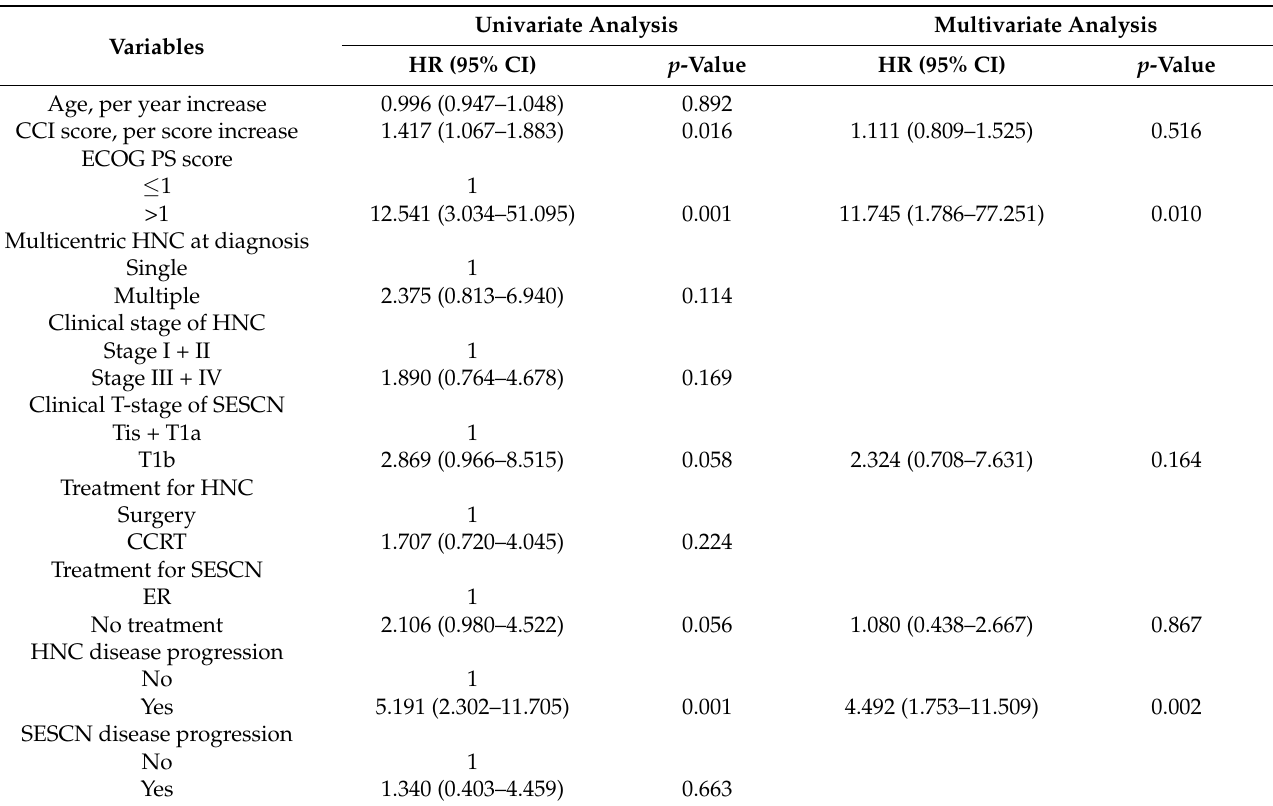
Table 3. Univariate and multivariate analysis of overall survival for overall